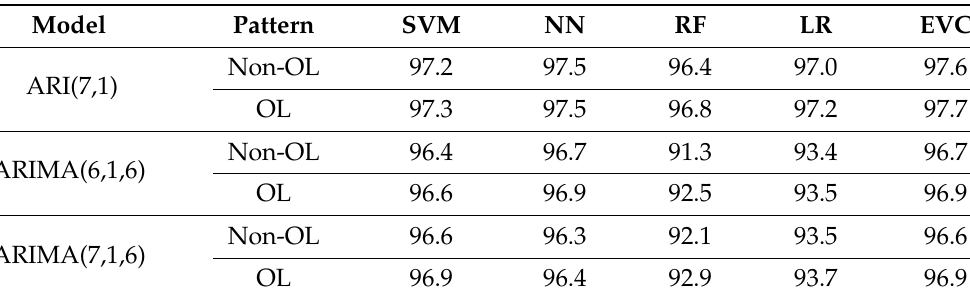
Table 5. Accuracy (%) of the global damage detection for different candidate models. Ensemble voting classifier